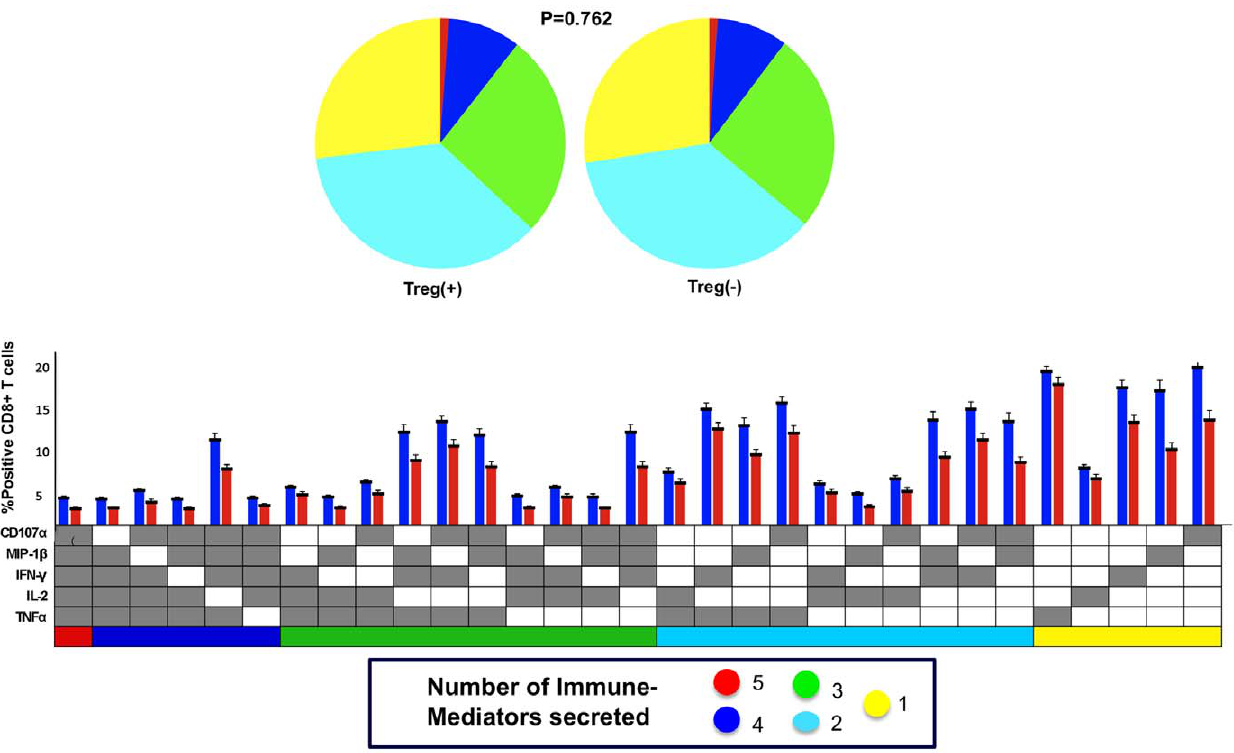
Figure 8. Comparison of response to Staphylococcus enterotoxin B (SEB) in samples with (Treg + ) and without Treg (Treg 2 ). Permutation comparison test showed no difference in the proportion of polyfunctional CD8 + T cells after Treg depletion. (P=0.762;